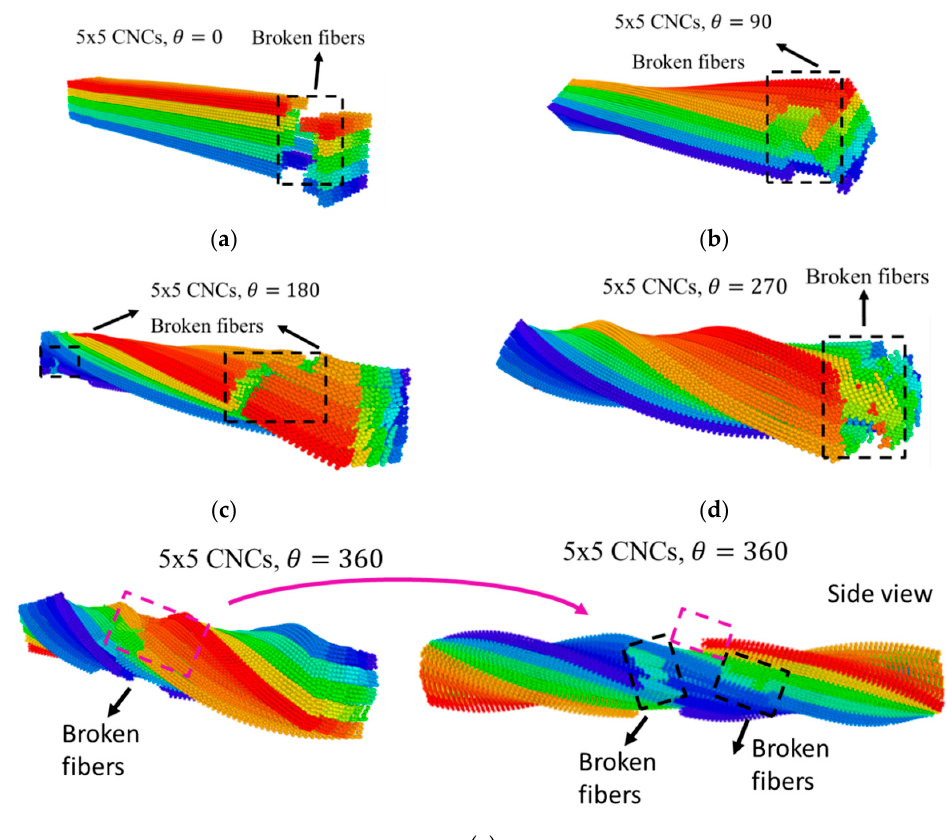
Figure 5. Failure of 5 × 5 CNC bundles for different θ and interfacial energy of 5.0 kcal/mol. ( a ) θ = 0, ( b ) θ = 90, ( c ) θ = 180, ( d ) θ = 270, and ( e ) θ = 360.